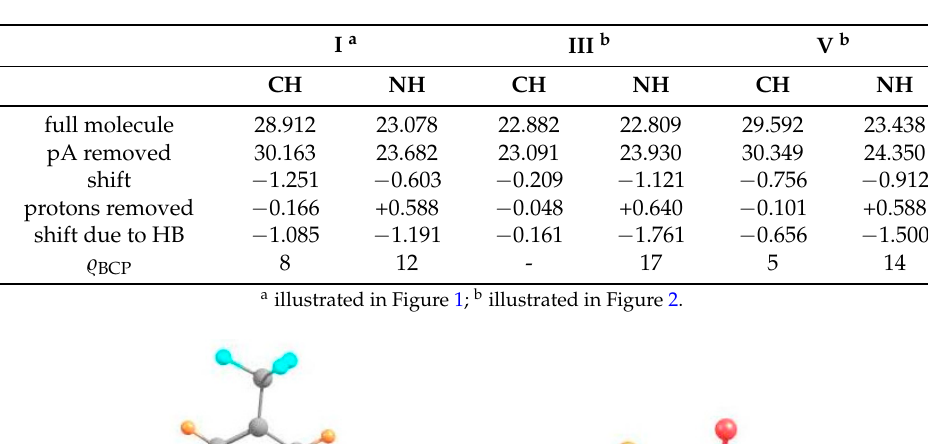
Table 1. NMR isotropic shielding (ppm) of molecules and indicated derivatives shown in Figures 1 and 2, along with density at bond critical points ( (cid:36) BCP ), in 10 − 3 au (mau).